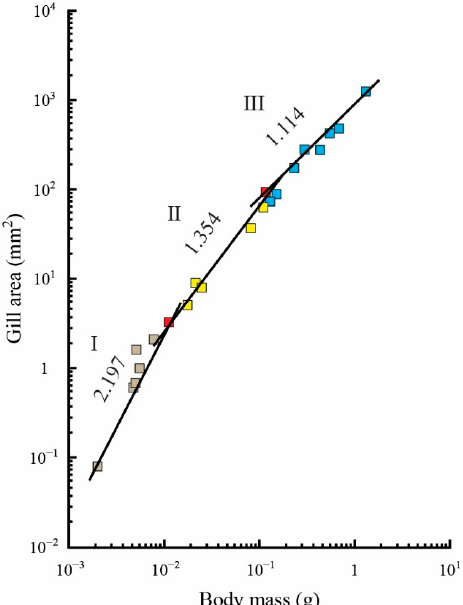
Figure 2. Allometric relationship between the gill area (colored squares) and body mass. The values above the regression lines indicate their slopes. The gill area was measured using the triangle method. The ontogenetic phase shifts in the gill area are presented as squares in three colors (gray, phase I; yellow, phase II; blue, phase III). Red-colored squares indicate the gill area measurements that overlap between phases I and II and between phases II and III.